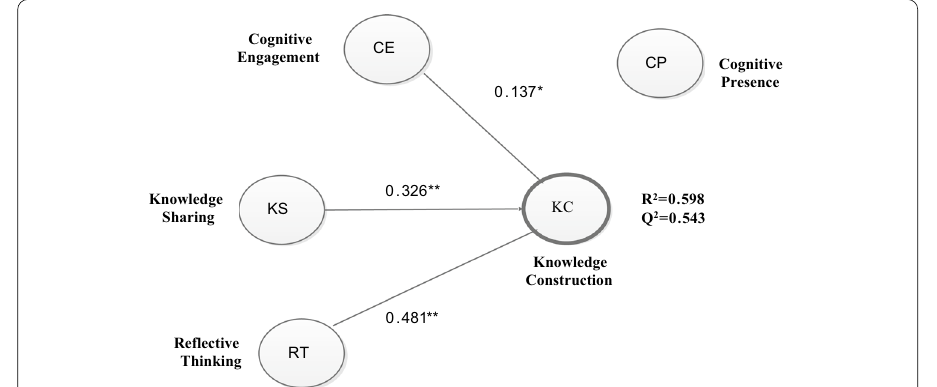
Fig. 6 Significant paths and quality of PLS‑SEM